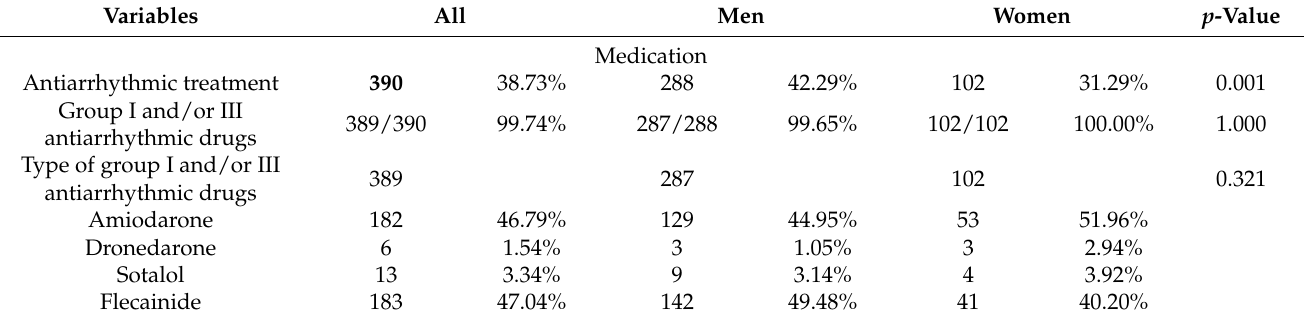
Table 8. Pharmacological